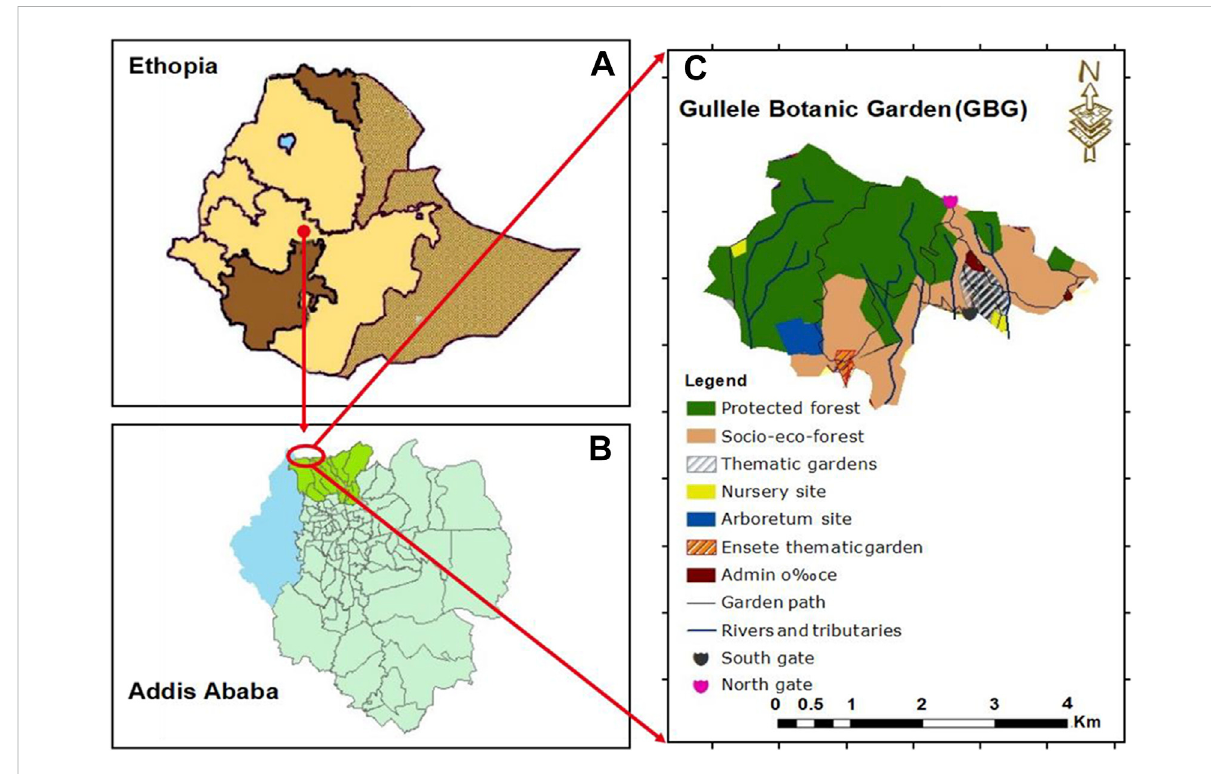
FIGURE 1 Map of Gullele Botanical Garden. The map shows (A) Ethiopia (B) the location of Addis Ababa in Ethiopia and (C) location of Gullele Botanical Garden and its various areas. Original maps drawn by Fikadu Erenso, Gullele Botanical